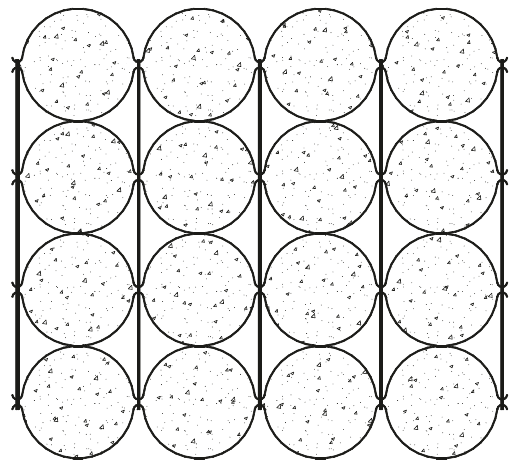
Figure 1: Structural scheme of one soil net layer.